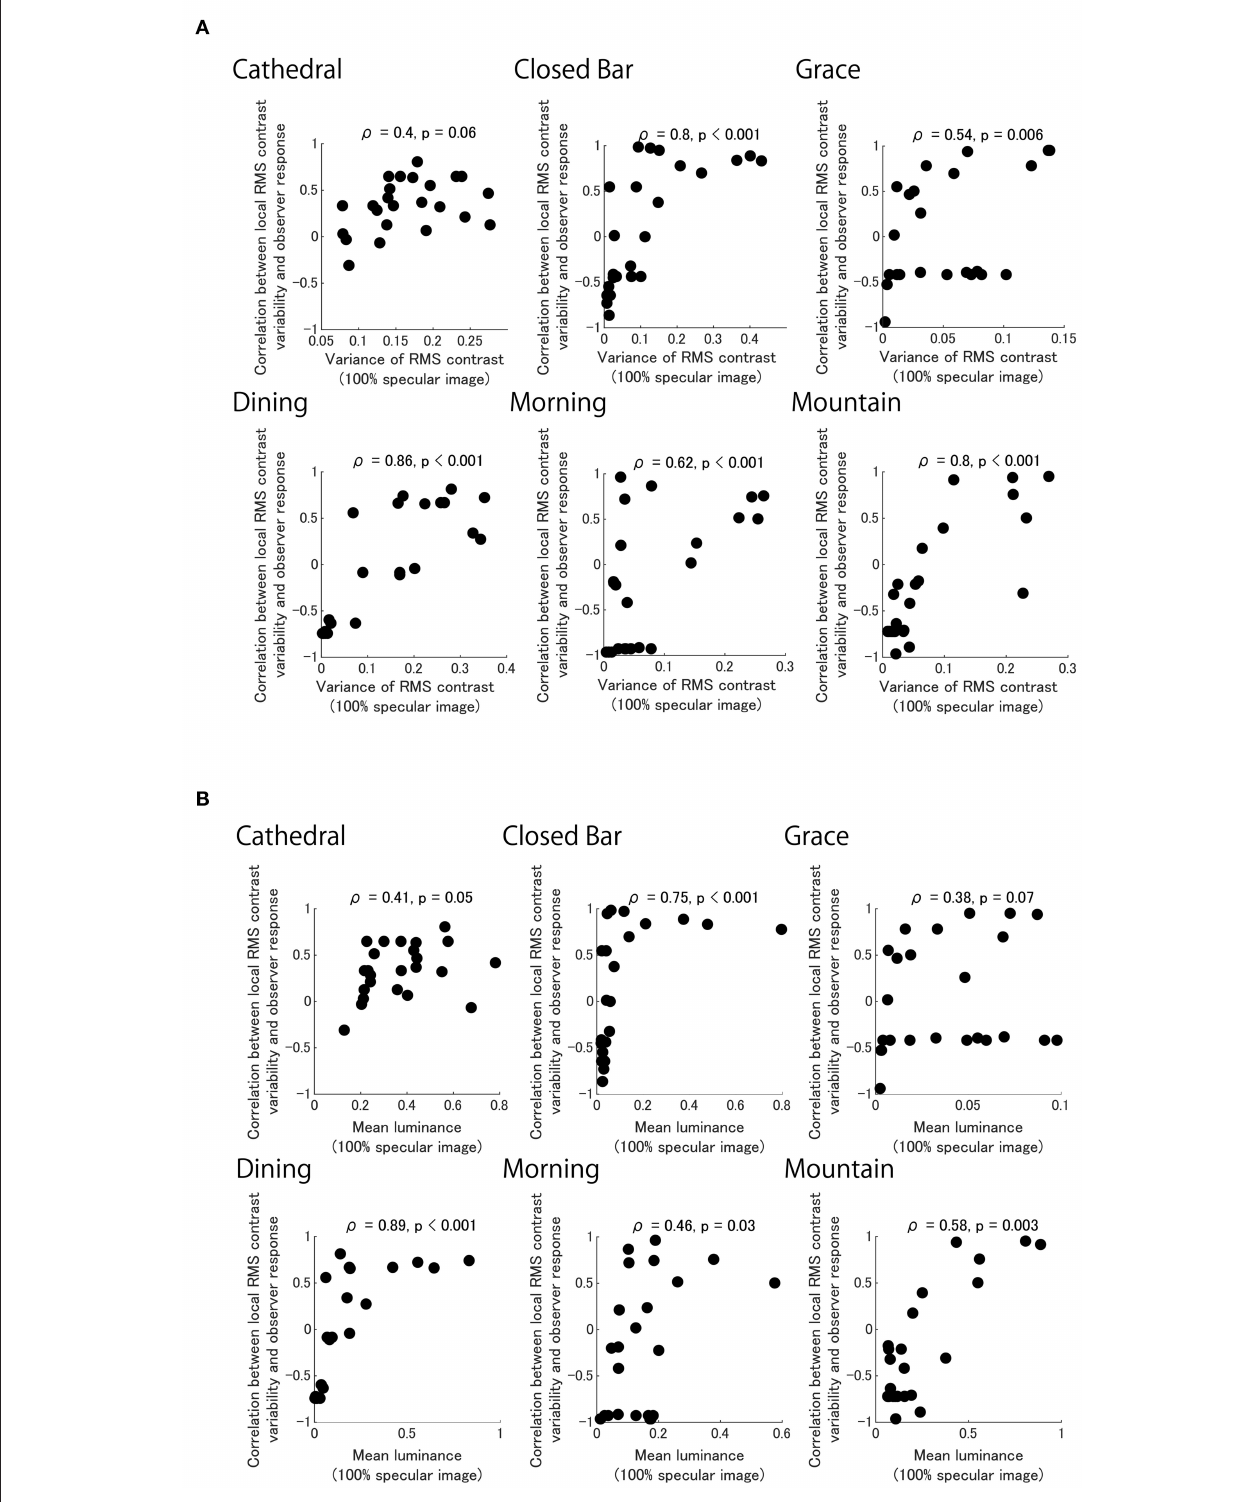
FIGURE 8 | Black dots show each of the 24 correlation coefficients for our model in each pixel region of images shown in Figure 6 plotted as a function of image parameters for the 100% specular image component ( Figure 7 ). Separate panels show model performance for six light fields plotted against variation in local RMS contrast (A) and local image luminance (B)